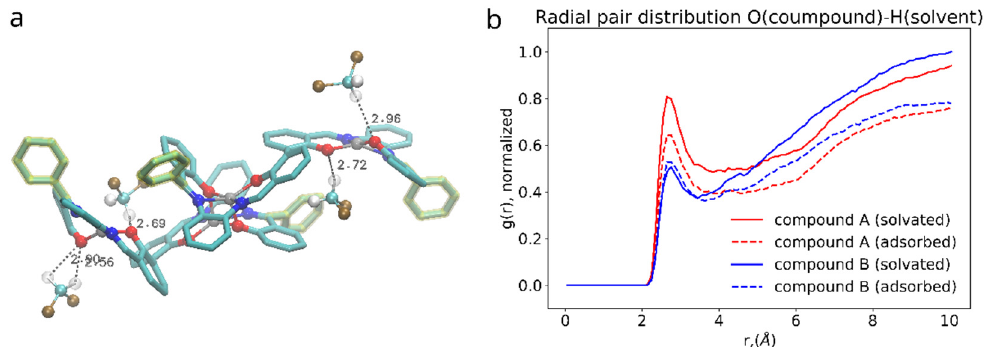
Figure 9. ( a ): 3D rendering of interaction between salphen’s oxygen and hydrogen of the DCM. ( b ): radial pair distribution function corresponding to this interaction for solvated (solid lines) and adsorbed (dashed lines) dimers.